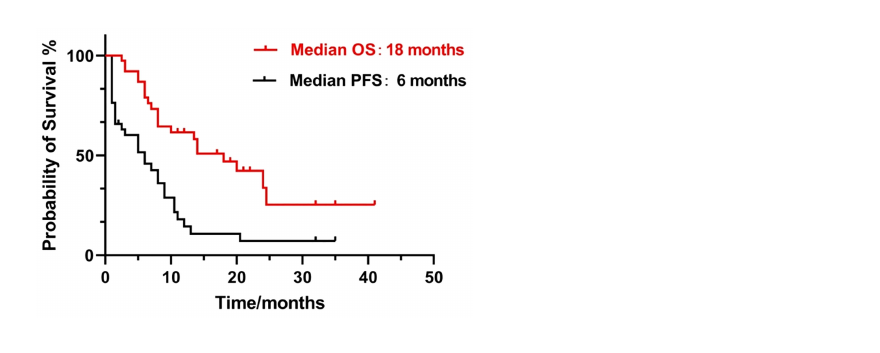
FIGURE 3 | Kaplan-Meier survival curve of PFS and OS time of 38 patients.